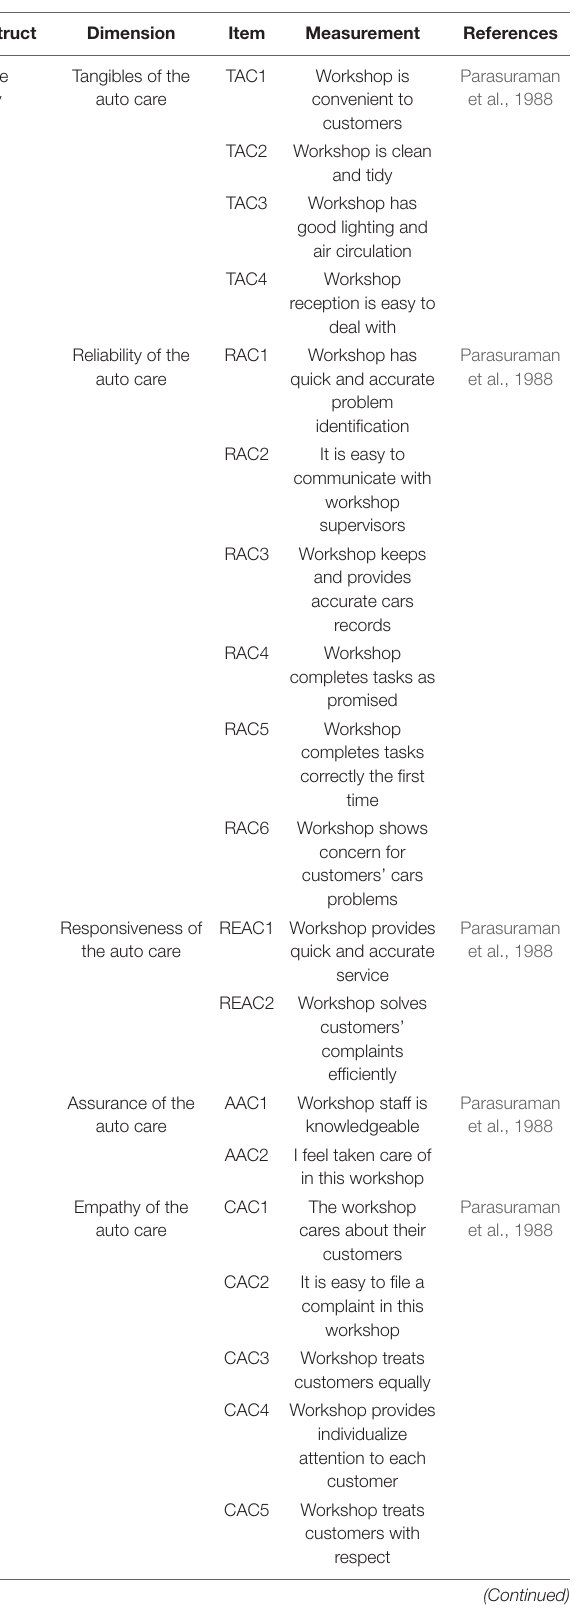
TABLE 2 | Constructs and items included in the